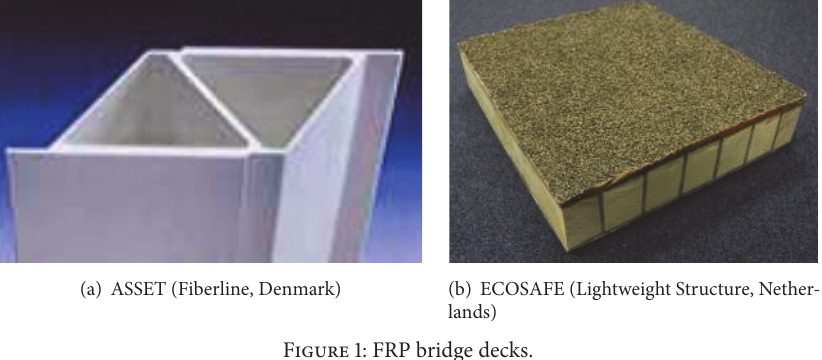
Figure 1: FRP bridge decks.